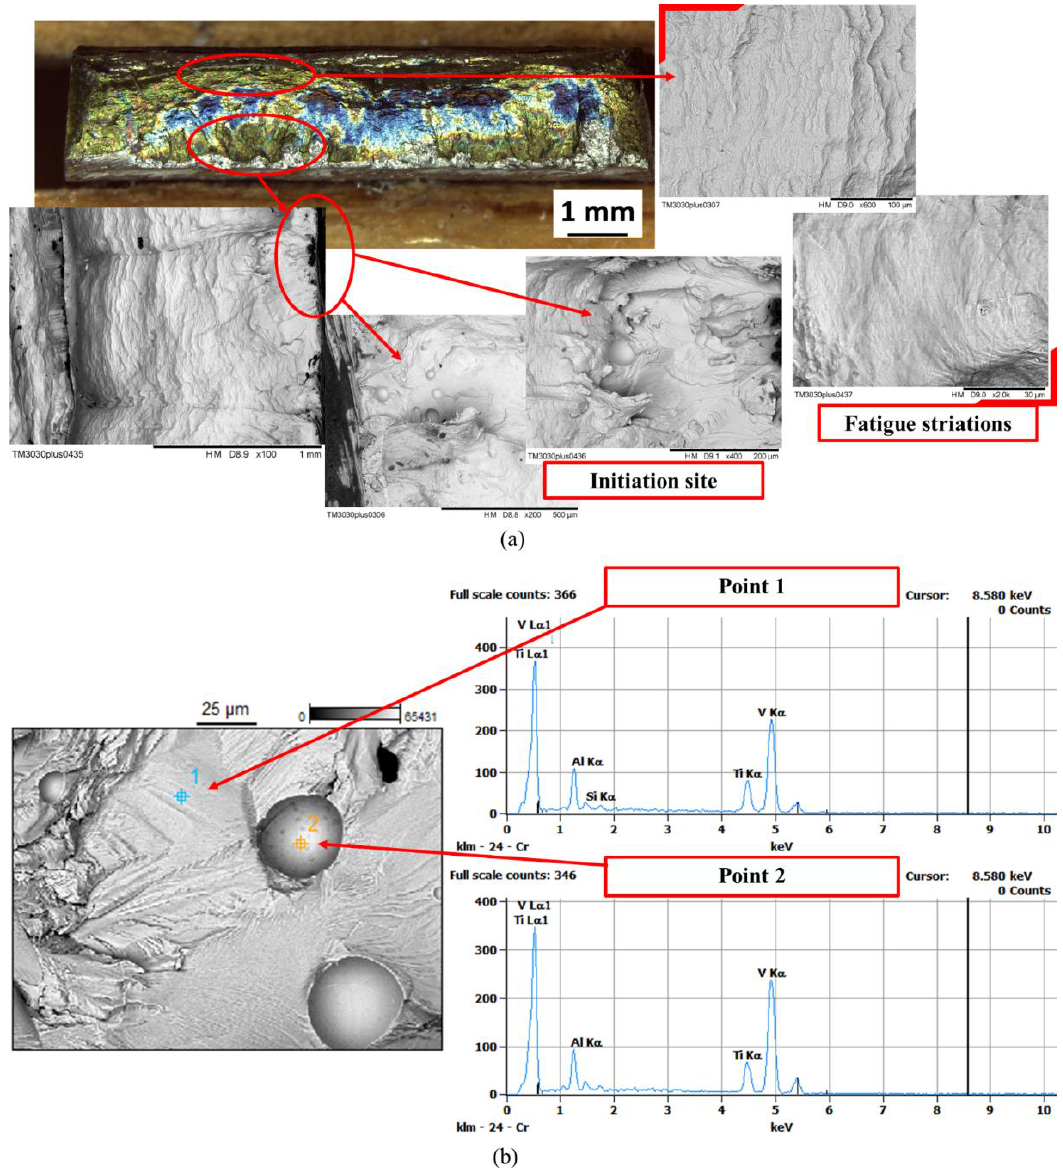
Figure 14. Fracture surface of the specimen tested at ∆ σ = 220 MPa and failed at 67,000 cycles (specimen 8): ( a ) Fractographies and ( b ) EDS spectra with the indication of the analyzed points.